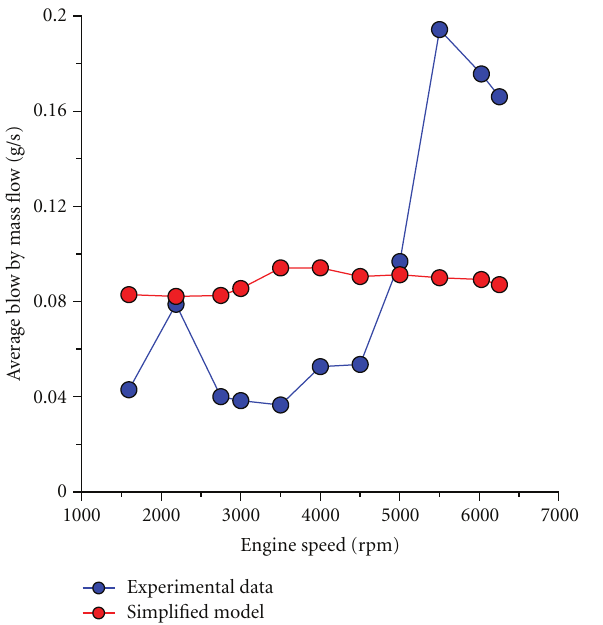
Figure 12: Experimental-simplified model Blow-by comparison.